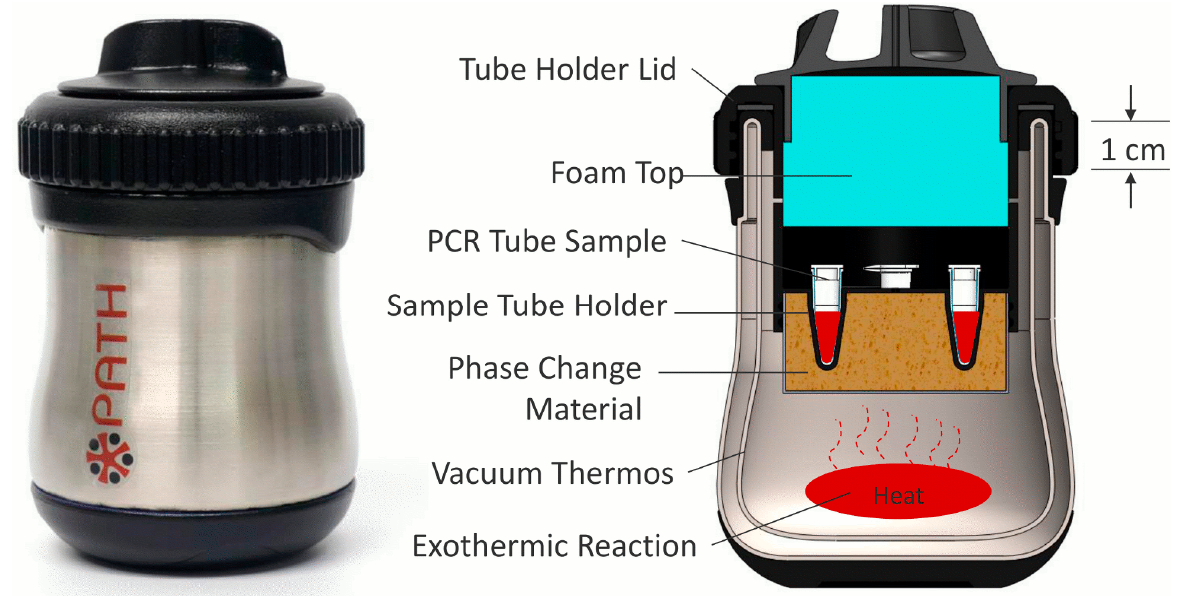
Figure 1. Cross-section showing the internal components of the LAMP-based device. Approximate dimensions of the heater are 80 mm in diameter by 120 mm in height. Reprinted with permission from ref.